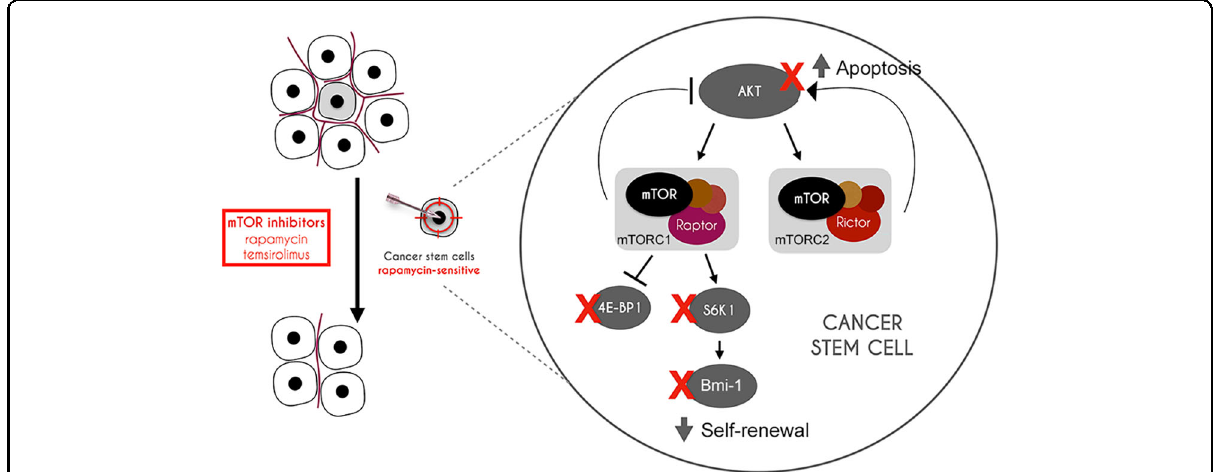
Fig. 7 Schematic view of the proposed mechanism underlying the effect of therapeutic inhibition of mTOR on cancer stem-like cells in mucoepidermoid carcinoma. As cancer stem-like cells exhibit constitutive activation of the mTOR pathway and are addicted to pro-survival signaling mediated by this pathway, effective inhibition of mTOR results in inhibition of Bmi-1 (self-renewal) and AKT activity. The net effect of these events is a decrease in the fraction of cancer stem-like cells in salivary gland mucoepidermoid carcinoma upon therapeutic inhibition of mTOR